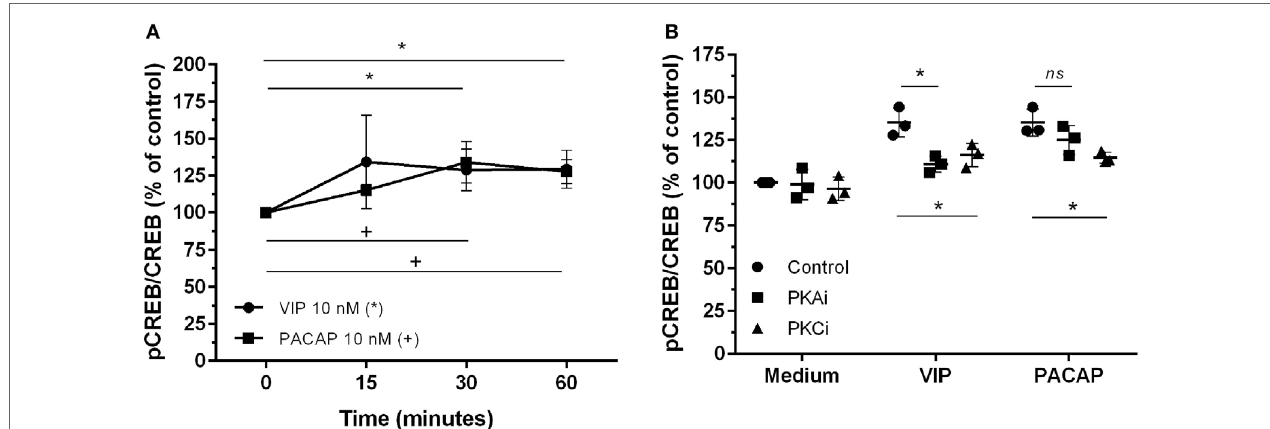
FigUre 5 | Vasoactive intestinal peptide (VIP) and pituitary adenylate cyclase-activating polypeptide (PACAP) promote cAMP response element-binding protein (CREB) phosphorylation in HIV-1-infected macrophages. (a) Uninfected macrophages were treated with VIP or PACAP (10 nM) and levels of CREB and phospho-S133 CREB were analyzed by ELISA at different time-points ( n = 3). (B) Infected macrophages were treated with VIP or PACAP (10 nM) in the presence or not of a protein kinases A (PKA) or C (PKC) inhibitors (PKAi, H89; PKCi, Gö 6983; 50 nM each one, for 30 min; cells were washed before neuropeptide addition), and CREB activation was analyzed 30 min after neuropeptide exposure ( n = 3). *, + p < 0.05; ns, not significant; two-way ANOVA, with Tukey